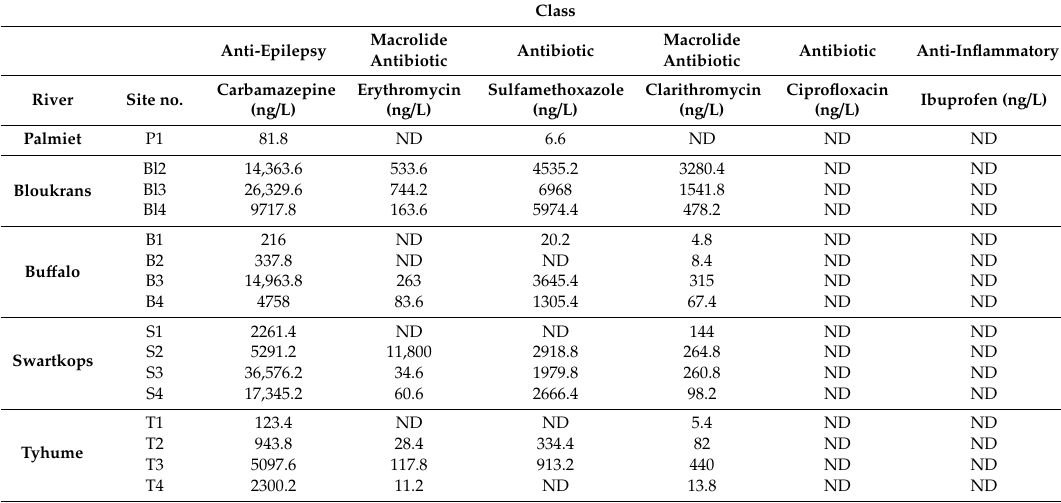
17,345.2 60.6 2666.4 98.2 T1 123.4 943.8 28.4 334.4 117.8 913.2 2300.2 11.2 ND 13.8 ND ND: not